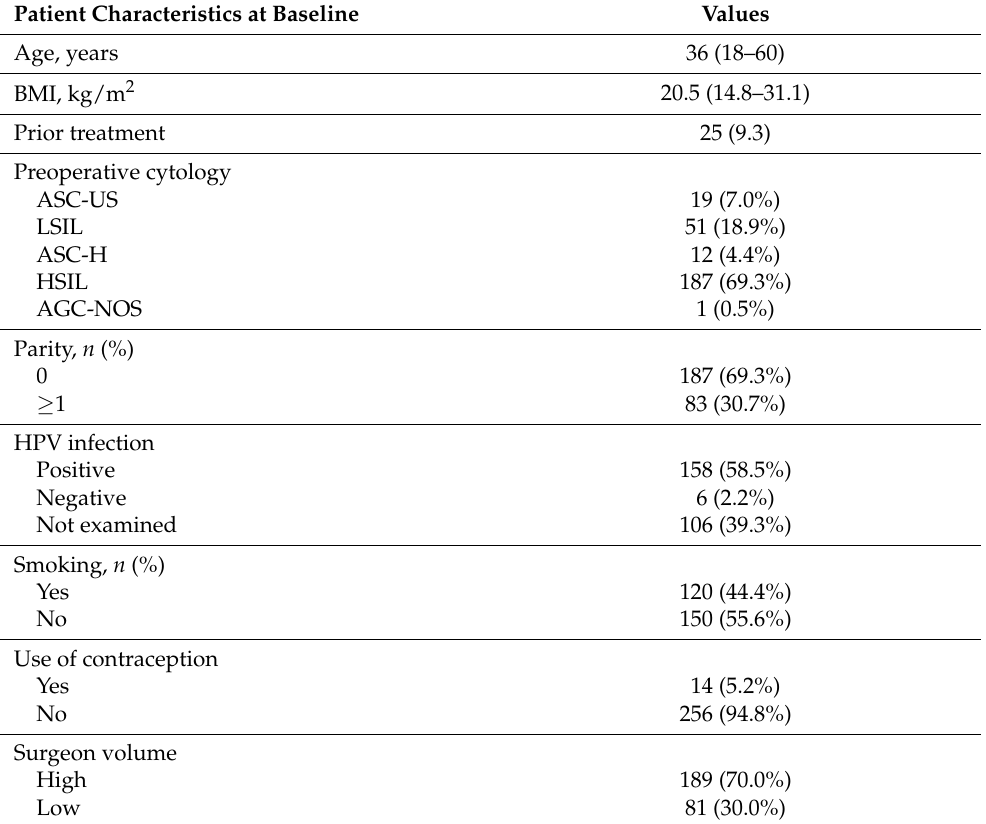
Table 1. Baseline characteristics ( n = 270).